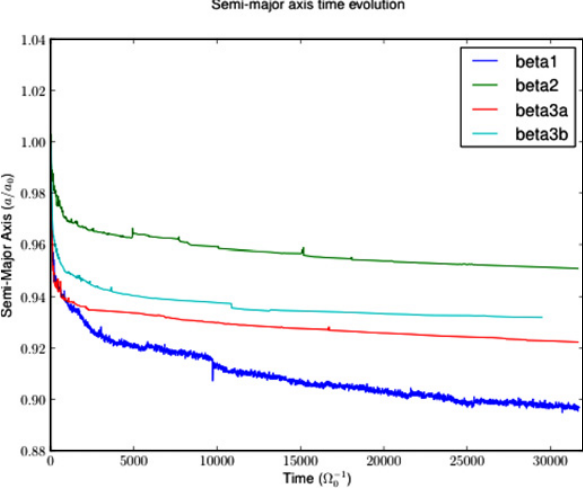
Figure 5. Accumulated stellar mass formed in the disc for our fragmentation simulations, scaled to a binary of 3 . 5 × 10 6 M (cid:4) . The shorter the cooling time, the fastest the disc turns its mass into stars. Figure from Amaro-Seoane et al. in prep.